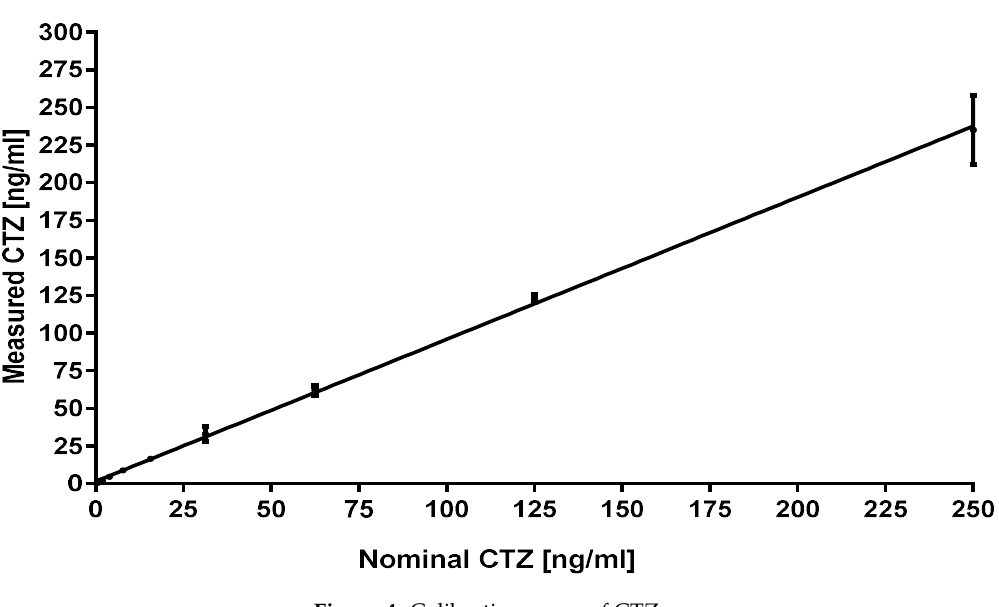
Figure 4. Calibration curve of CTZ.